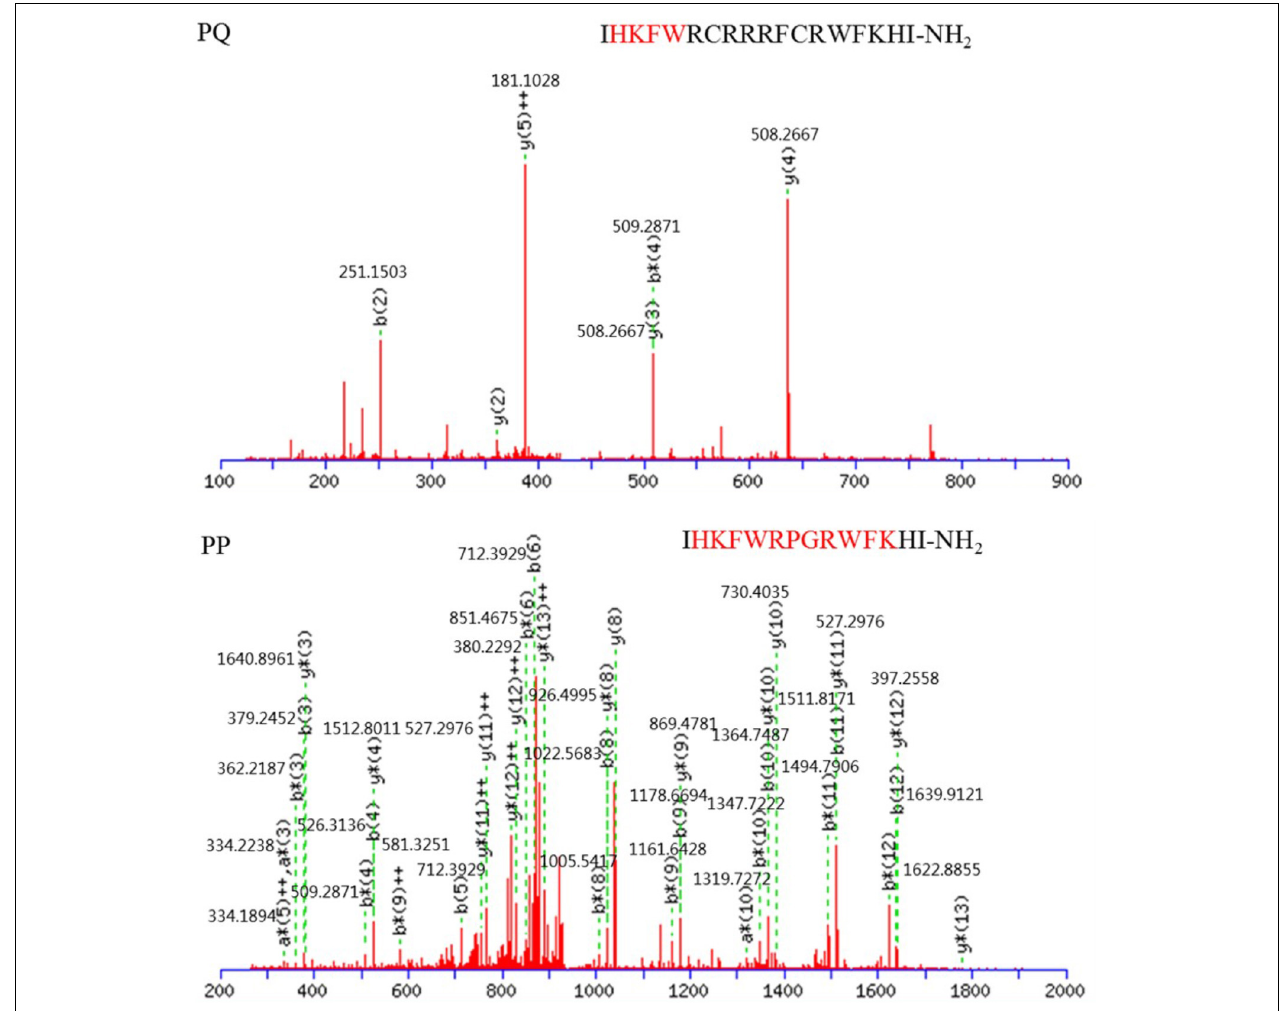
FIGURE 5 | MS/MS spectra of precursor ions that correspond to peptides PQ and PP. Red font is reserved peptide.